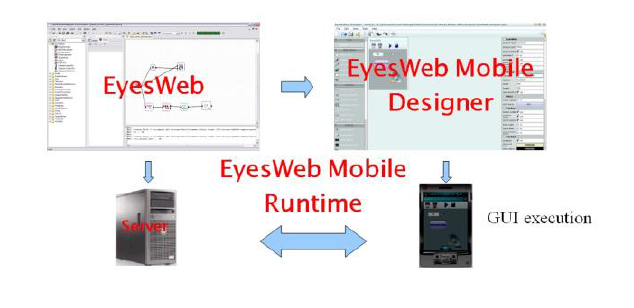
Figure 6. Interaction between EyesWeb Mobile tool and EyesWeb